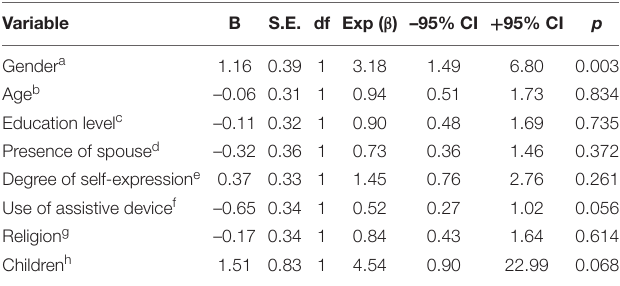
TABLE 3 | Summary of logistic regression analysis for the preference of physical and social activities.